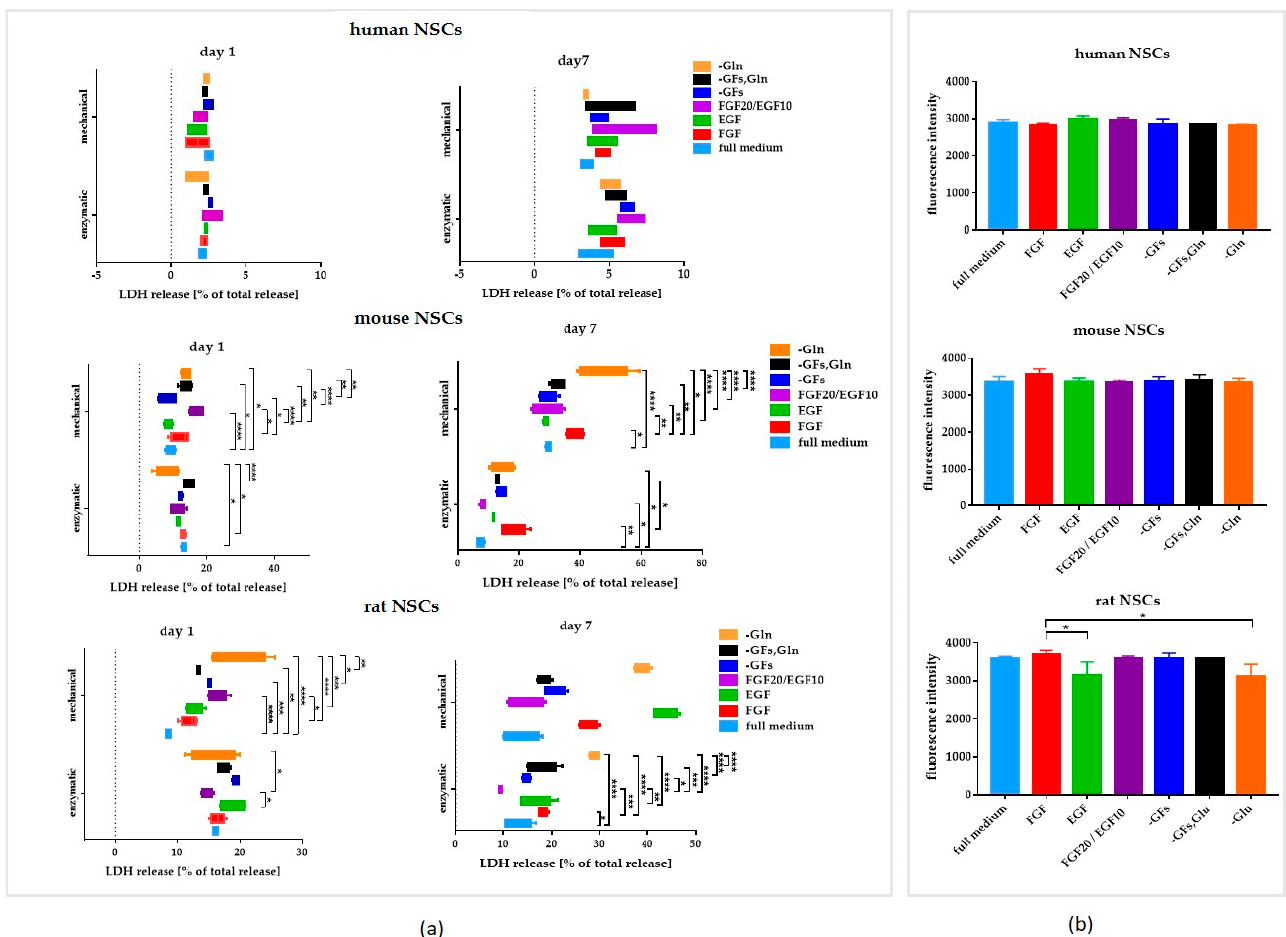
Figure 6. The influence of the medium composition on the viability and senescence of NSCs. ( a ) LDH release of NSCs on Day 1 and Day 7 of culture after enzymatic/mechanical dissociation. ( b ) Senescence activity of NSCs after Day 7 of culture. Cell culture conditions: 5% O 2 , 5% CO 2 , 37 °C, N = 3. The results of all presented experiments are expressed as mean values of three experiments ± SEM. The differences were considered statistically significant when the p -value < 0.05. Statistical significance level: * for 0.01 < p < 0.05, ** for 0.001 < p < 0.01, *** for 0.0001 < p < 0.001, and **** for p < 0.0001.